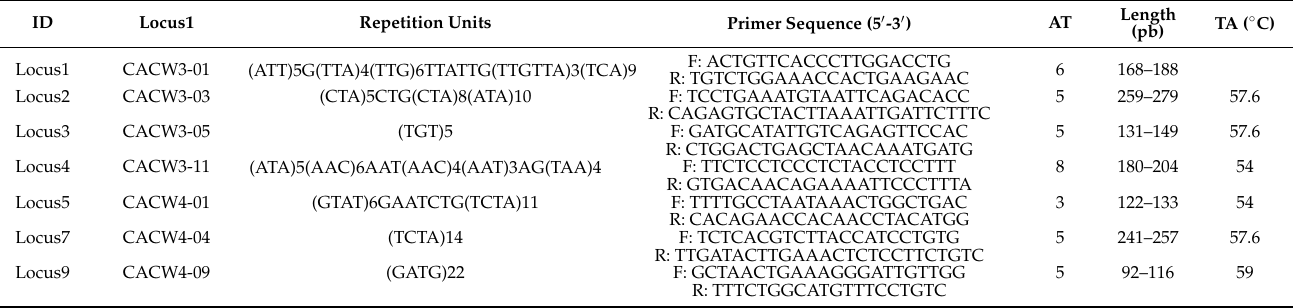
Table A1. Microsatellite loci information used to analyze the genetic diversity of Campylorhynchus yucatanicus in the north tip of the Yucatan Peninsula, Mexico. Total number of alleles (AT) and alignment temperature (TA). 1 Barr et al. (2015).